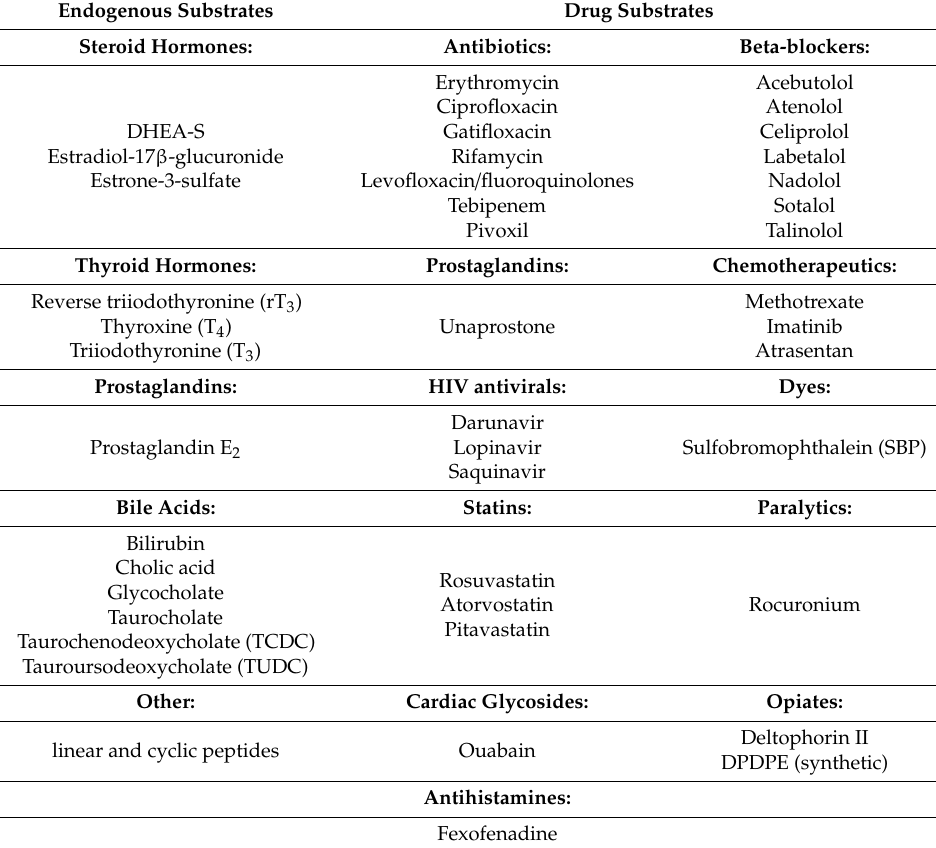
Table 2. A list of representative substrates for the solute carrier family 21 (SLCO) transporter OATP1A2. Endogenous substrates are on the right panel. Frequently prescribed drugs that are substrates for OATP1A2 are listed in the middle and left panel. Drugs are clustered by therapeutic class and this list in not exhaustive. Endogenous transport substrates of OATP1A2 include bile acids and linear and cyclic peptides, steroid conjugates, the thyroid hormones T4, T3 and rT3, prostaglandin E2. Pharmacologic and other exogenous transporter substrates for OATP1A2 include antibiotics, synthetic prostaglandins, HIV antivirals, 3-hydroxy-3-methylglutaryl coenzyme A (HMG-CoA) reductase inhibitors (statins), natural product cardiac glycosides, antihistamines, beta adrenergic blocking agents (beta blockers), chemotherapeutics, the synthetic opioid receptor agonists [D-Pen2,D-Pen5]enkephalin (DPDPE) and deltorphin II, certain magnetic resonance imaging contrast agents, and the dye sulfobromophthalein